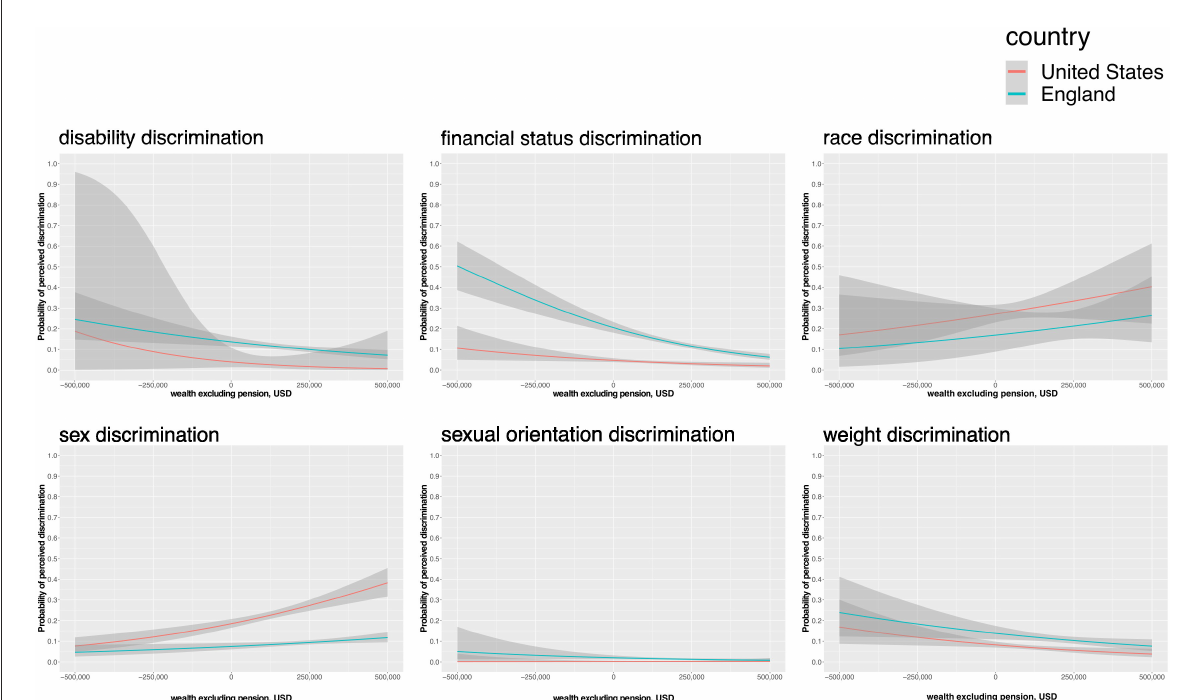
FIGURE2 Probability of perceived discrimination (95%CI) predicted by wealth (USD) in England and US. Y-axis: the probability of perceived discrimination (yes, no); x-axis: wealth (USD)—a net sum of dept, financial wealth, housing, and physical wealth (i.e., land and jewelry). The probability of perceived discrimination predicted by wealth (USD) in England (green) and US (red) with 95% CI (in gray). Plots are produced from datasets restricted to the respective demographic or biometric characteristics [i.e., physical limitation, wealth > sample median (i.e., low socioeconomic position), ethnic minority, women, and BMI > 30]. Sexual orientation discrimination was not restricted to LGB. Wealth (USD). The analysis included ELSA (England) and HRS (US) cohorts.